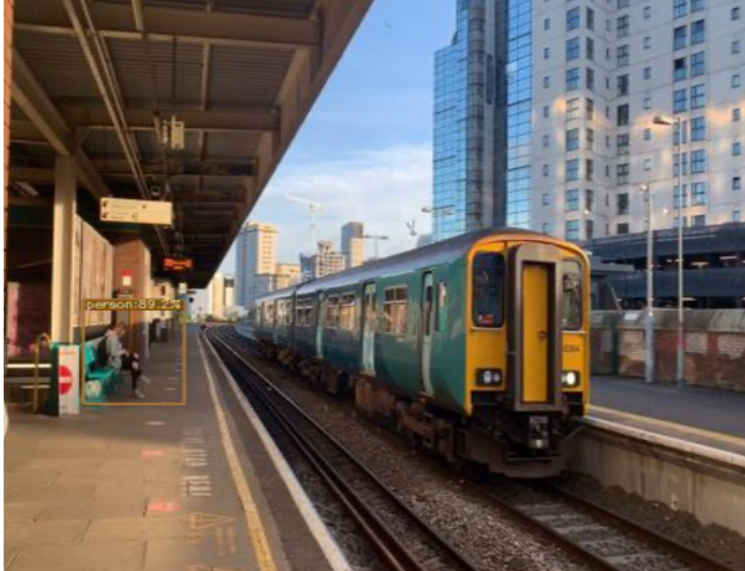
Figure 8. Object detection results of YOLOX on custom